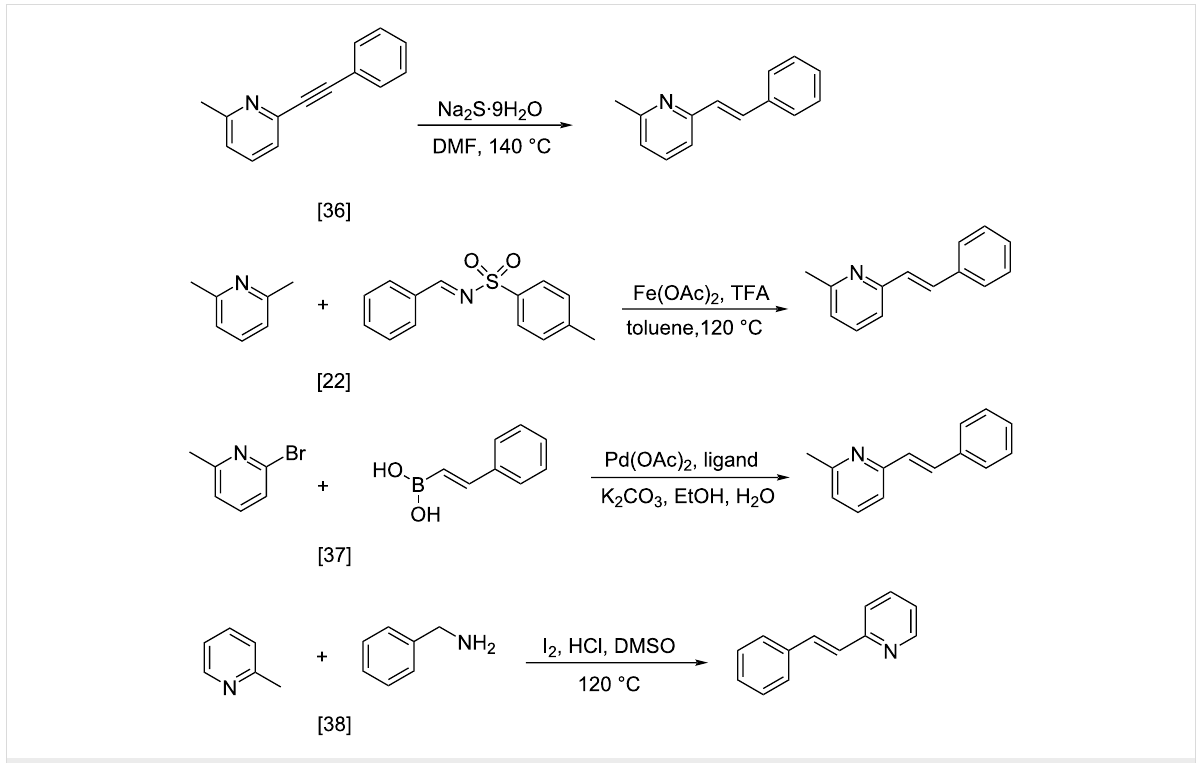
Scheme 2: Synthesis of azaarene derivatives from different precursors.